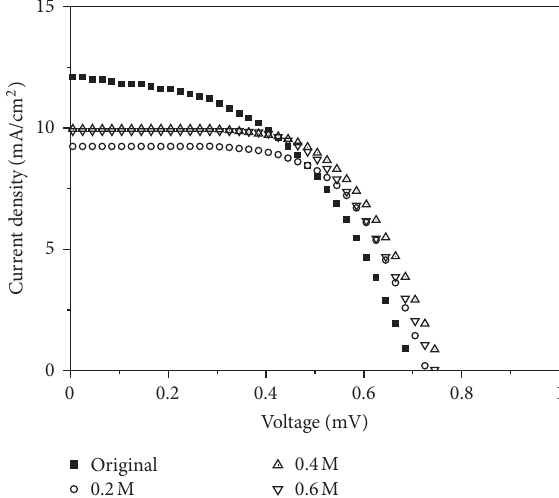
F 4: ephotovoltaic curves ( J - V ) of the DSSC based on the composite electrolytes with 1-butyl-3-methylimidazolium iodide at different molalities.